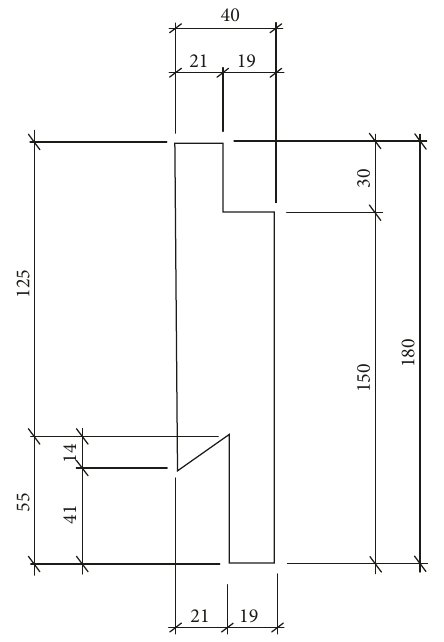
Figure 6: Sketch of prefabricated hanger slab. Unit: mm.